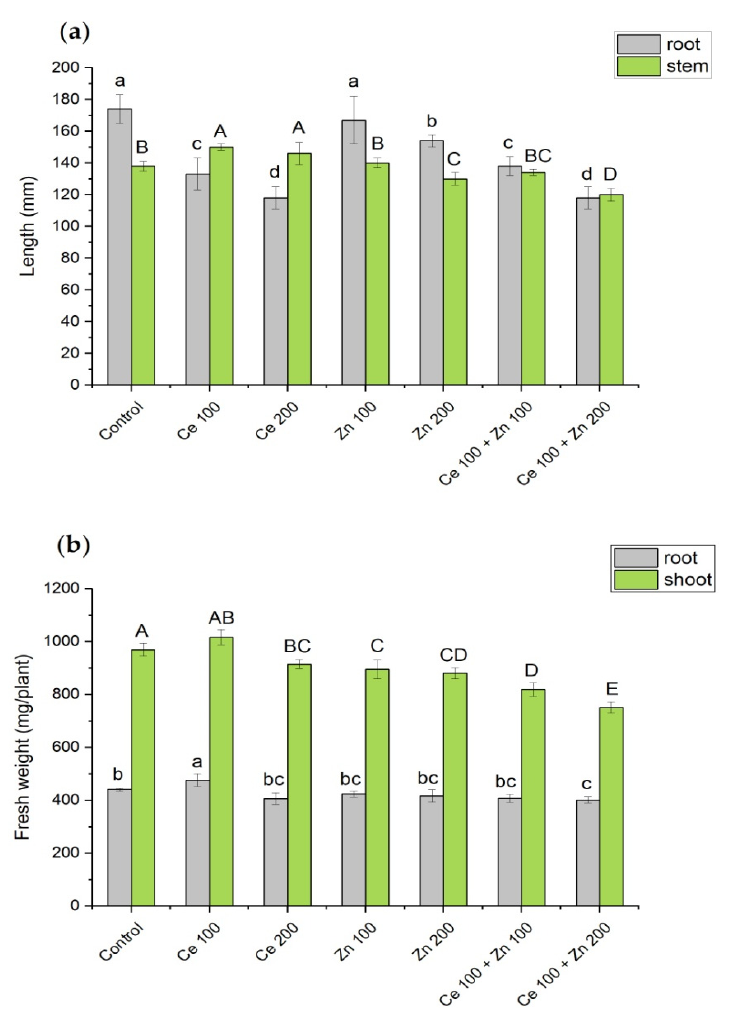
Figure 1. The influence of nanoparticulate CeO 2 and ZnO on: ( a ) root and stem length and ( b ) fresh weight of root and shoot as determined for a single pea plant. Concentrations of nanoparticles are given in mg/L of elemental cerium or zinc, the cultivation time was 12 days. Roots are represented by grey while above-ground parts are in green. Vertical bars represent standard deviations ( n = 6). Distinct letters show the statistically significant differences among treatments as calculated with Tukey’s HSD post hoc test. The probability level p = 0.95 was